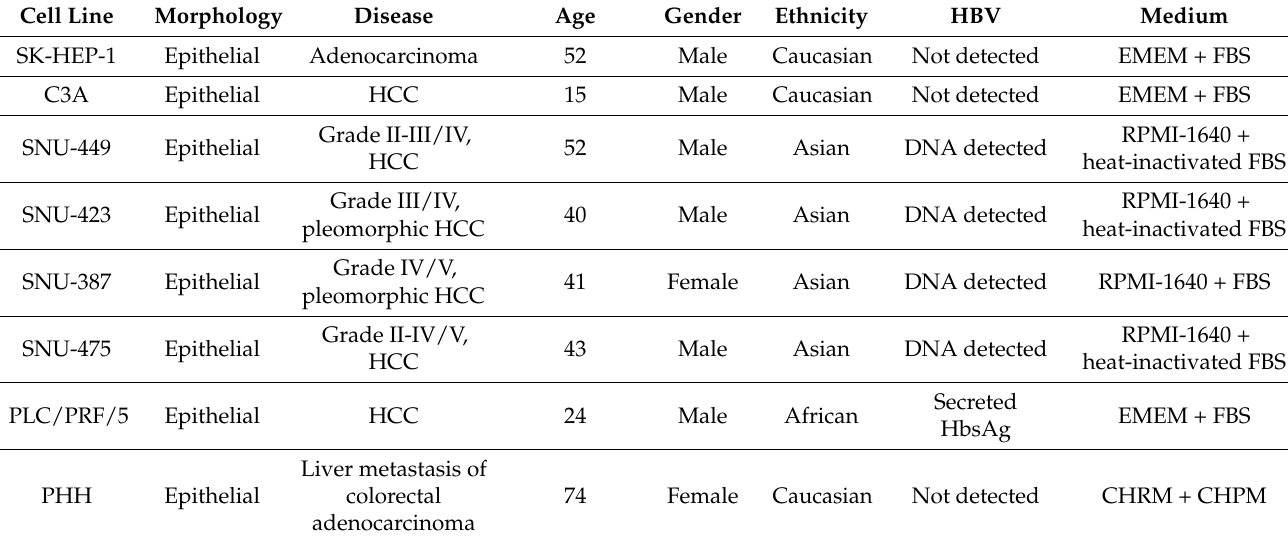
Table 1. Overview of the liver cancer cell lines and primary human hepatocytes (PHH). Specifications for all cell types used in this study, including morphology, disease, age, gender, ethnicity, hepatitis B virus (HBV) infection of the donors and used cell culture medium (HCC, hepatocellular carcinoma; EMEM, Eagle’s minimum essential medium; FBS, fetal bovine serum; RPMI-1640, Roswell Park Memorial Institute 1640 Medium; CHRM, cryopreserved hepatocyte recovery medium; CHPM, cryopreserved hepatocyte plating